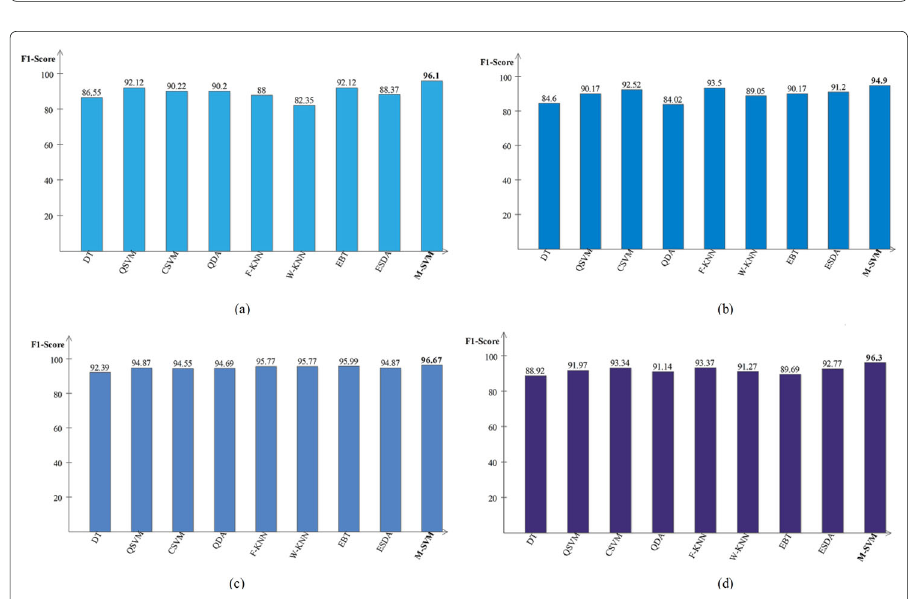
Fig. 16 F1 score of the proposed feature selection algorithm. a F1 score for apple rot. b F1 score for apple rust. c F1 score for grapes rot. d F1 score for grapes leaf